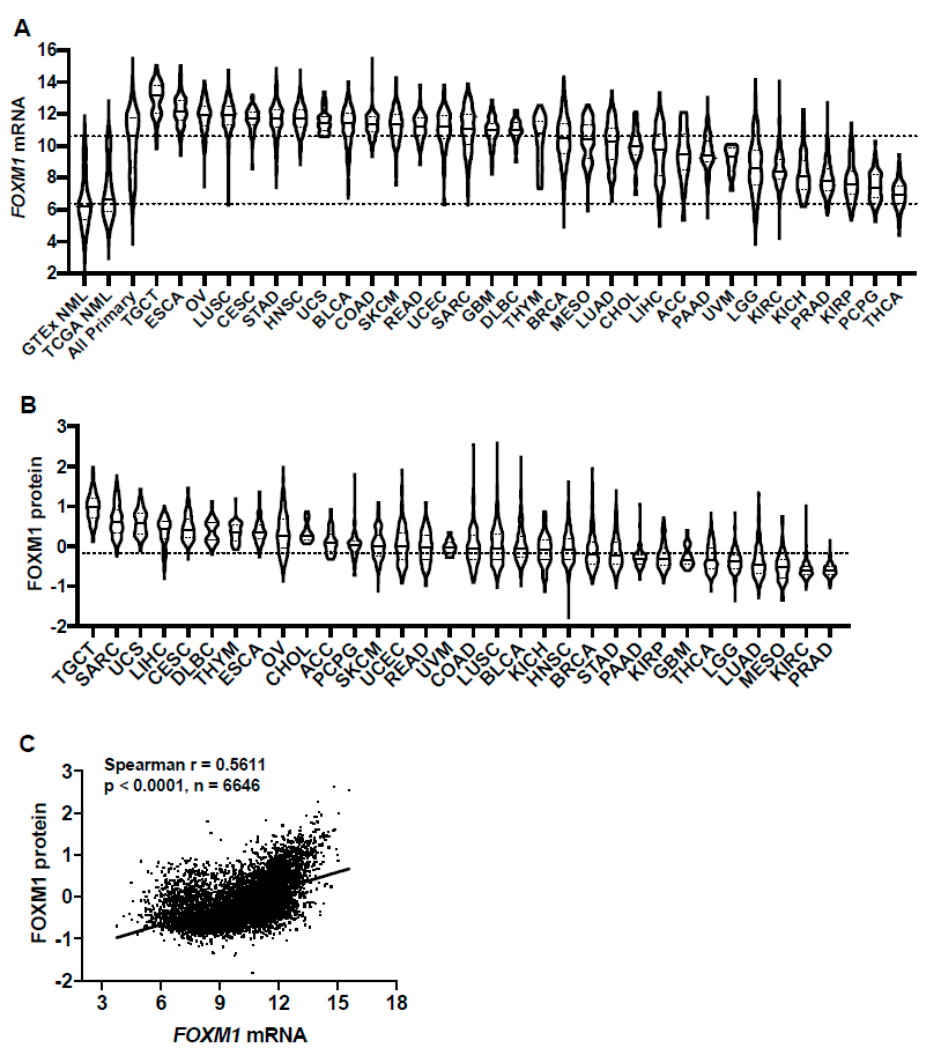
Figure 1. FOXM1 mRNA and protein expression in genotype-tissue expression (GTEx) normal, The Cancer Genome Atlas (TCGA) normal, and TCGA cancer tissues. ( A ) FOXM1 mRNA expression (RNA-seq RSEM, log2(norm count +1)) in GTEx and TCGA datasets. Sample lines represent medians and quartiles. Low and high dotted lines across the graph represent median expression for GTEx and TCGA normal, and TCGA cancer, respectively. Cancer types consist of primary tumors only and are ranked by median FOXM1 mRNA expression. The key to all TCGA abbreviations is shown in Table S1. ( B ) FOXM1 protein expression (Reverse Phase Protein Array; RPPA, pan-can normalized) across TCGA cancer types. ( C ) FOXM1 mRNA expression (RNA Seq V2 RSEM, log2(norm count +1) correlations with FOXM1 protein expression (RPPA, pan-cancer normalized)) across TCGA cancer types.